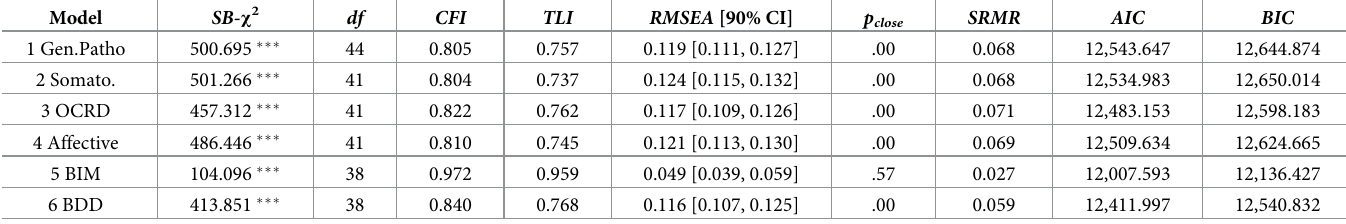
Table 3. SEM fit statistics for six competing models in the complete sample.